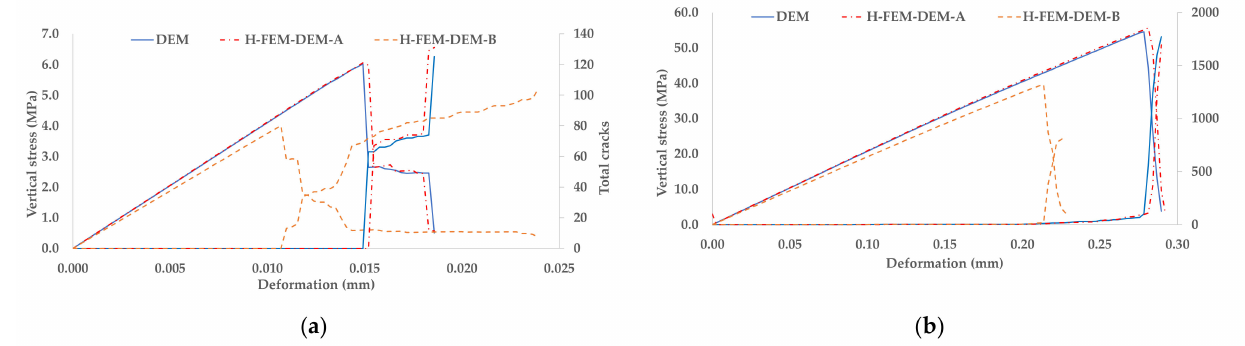
Figure 7. Stress/Deformation diagram and crack evolution for uniaxial tests: ( a ) tensile test; ( b ) compression test.